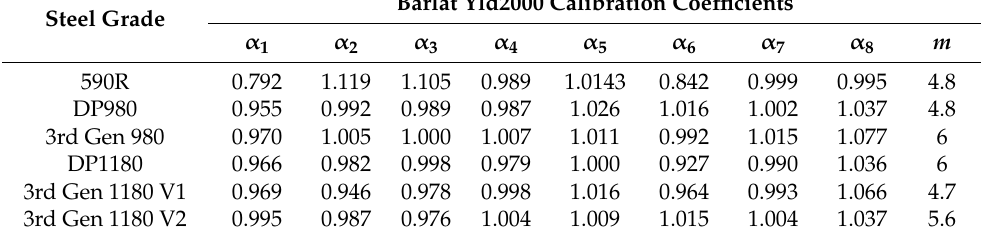
Figure 9. Calibrated Barlat Yld2000 yield surface for the 3rd Gen 1180 V2 ( a ) and predicted stress ratios ( b ). Table 6. Calibration coefficients of the Barlat Yld2000 yield function. Note that the data for the DP1180 was retrieved from the study of Butcher et al. [14] and the 3rd Gen 980 and 1180 V1 from Gutierrez et al. [12].